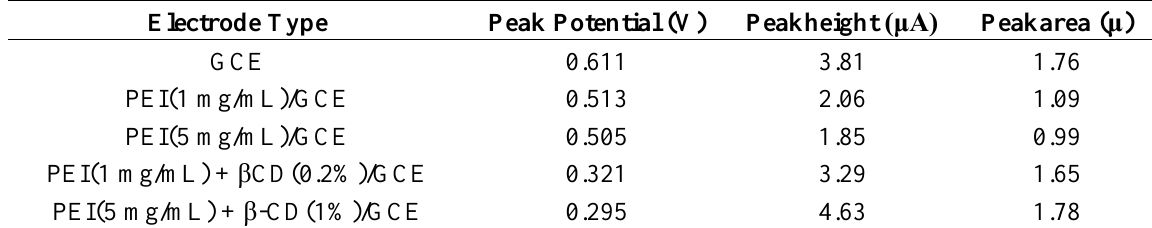
Table 2. SWV parameters for 10 −3 M AA on different electrodes.